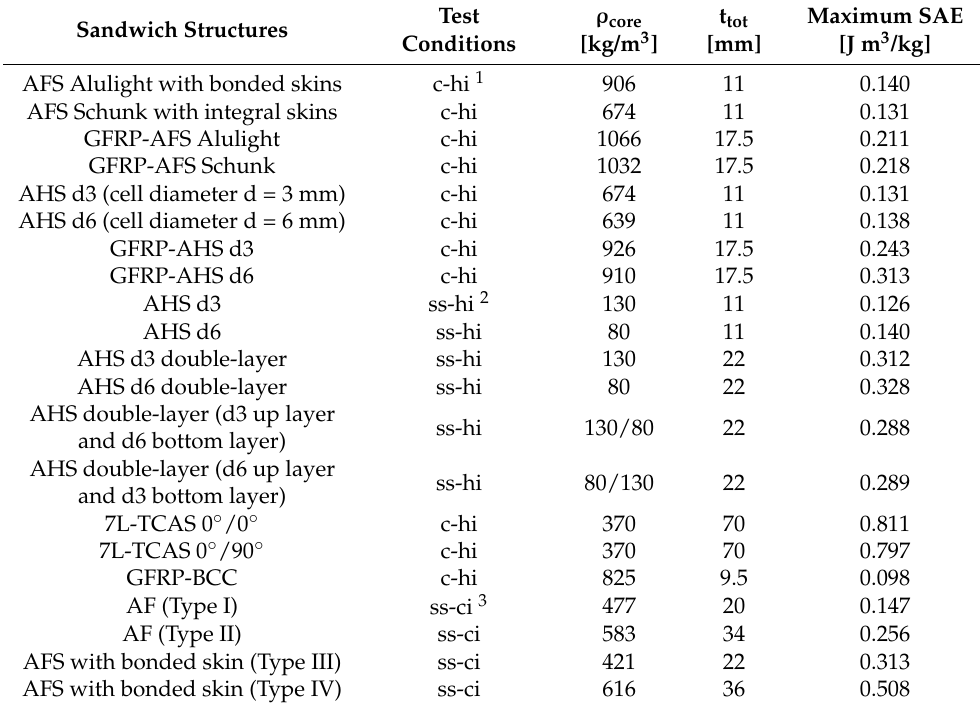
Table 2. Comparison of the maximum specific absorbed energy ( SAE) among different sand- wich structures.